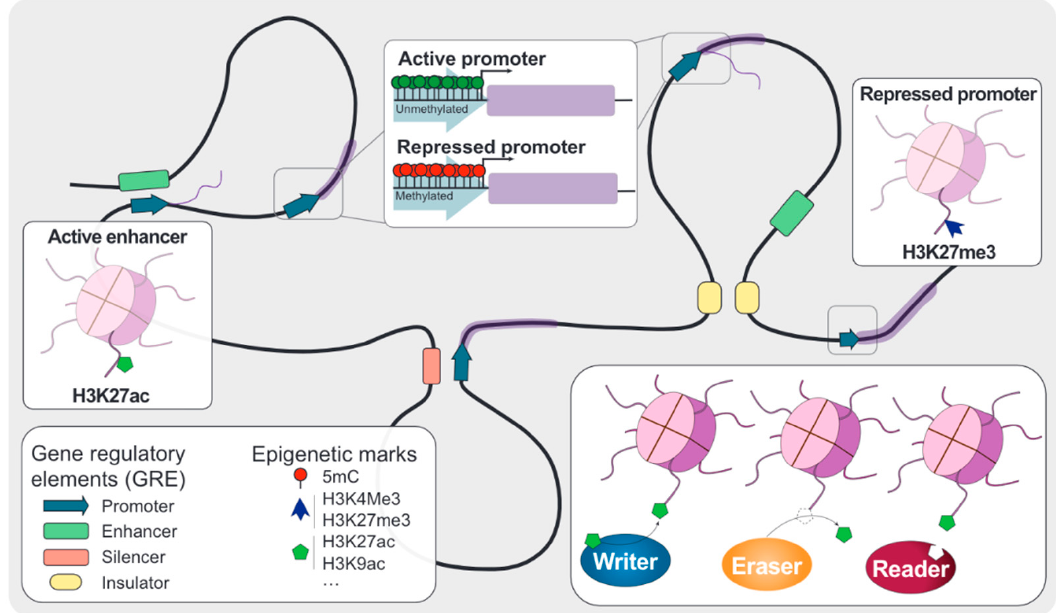
Figure 1. Overview of epigenetics. Gene regulatory elements (GRE) are defined according to their location and effect on the associated gene expression. Promoters are located close to the transcription start site of their associated genes and facilitate the transcription machinery deposition. This deposition can be aided or blocked by distant GRE called enhancers and silencers, respectively. Chromatin architecture is dynamically regulated by another group of GRE called insulators, which mediate in the topological associating domains (TADs) formation and further contributing to gene expression. DNA and histone modifications are tightly regulated by three different groups of proteins: writers, which are involved in the deposition of these chemical marks; erasers, which are responsible for removing these modifications; and readers, which can recognize the epigenetic code and recruit other proteins.